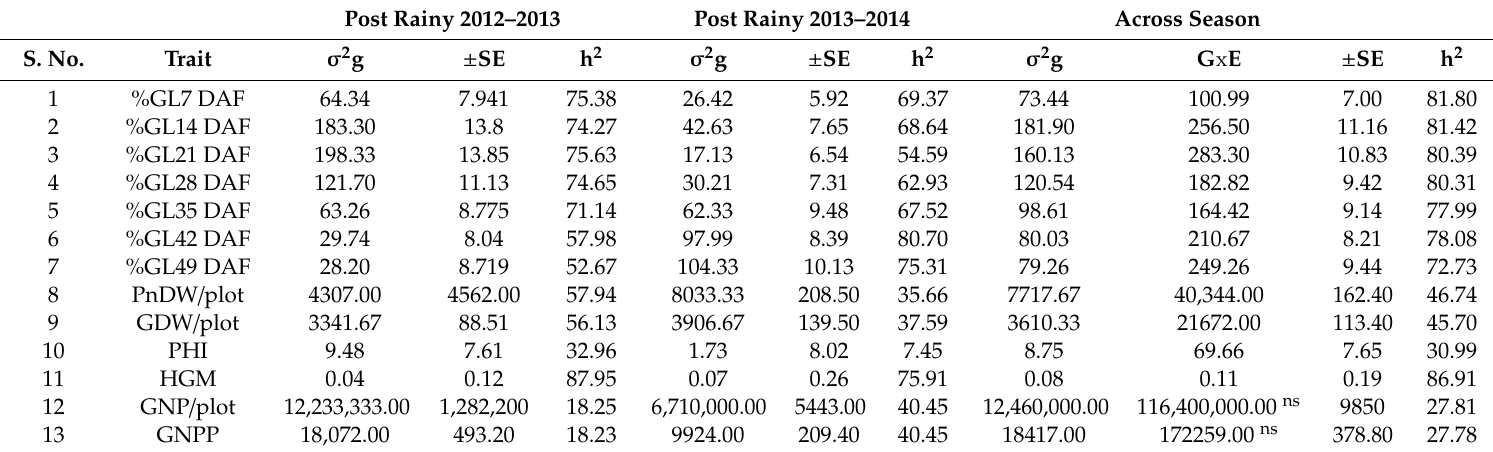
Table 2. Genotype variance, genotype × environment, standard error, and heritability estimates (on the mean basis) for stay-green scores derived from cross RSG04008-6 ×